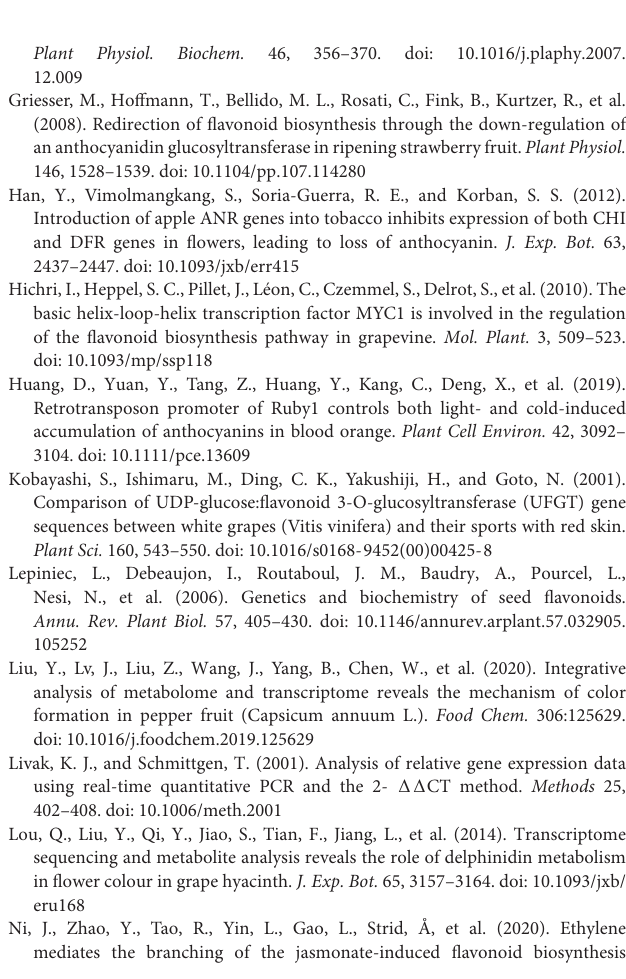
Supplementary Figure 1 | (A) Total ion current of one quality control sample by mass spectrometry detection and (B) multi-peak detection plot of metabolites in the multiple reaction monitoring mode. The abscissa represents the retention time (min) of metabolite detection, and the ordinate represents the intensity of the ion current (cps: count per second). (C) The overall cluster diagram of the sample. Supplementary Figure 2 | Grouping principal component analysis diagram. The x -axis represents the first principal component and the y -axis represents the second principal component. Supplementary Figure 3 | (A) Scores opls-DA plot. (B) OPLS-DA verification plot. (C) OPLS-DA S-plot. (D) Differences metabolites clustering heat maps. Supplementary Figure 4 | (A) Sample correlation heat map. (B) Gene principal component analysis diagram. (C) Correlation coefficient clustering heat